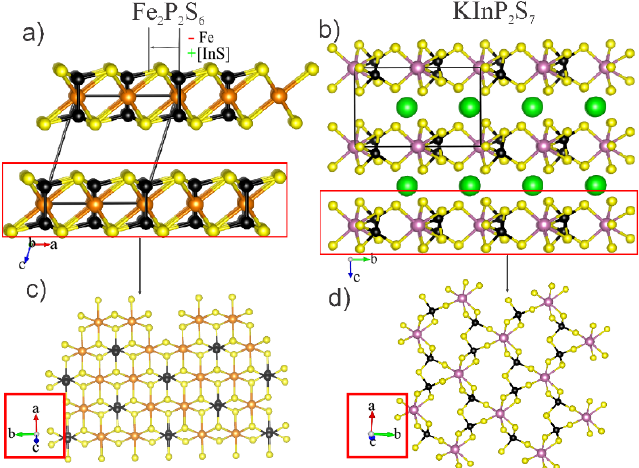
Figure 2. ( a ) Ball-stick structure of Fe 2 P 2 S 6 viewed along [010] direction, ( b ) ball-stick structure of KInP 2 S 7 viewed along [100] direction, ( c ) a detailed view of [FeP 2 S 3 ] layers within Fe 2 P 2 S 6 viewed along [101] direction, ( d ) a detailed view of [InP 2 S 7 ] − layer within KInP 2 S 7 viewed along [101] direction. Fe: orange, P: black, S: yellow, K: green, In: pink.